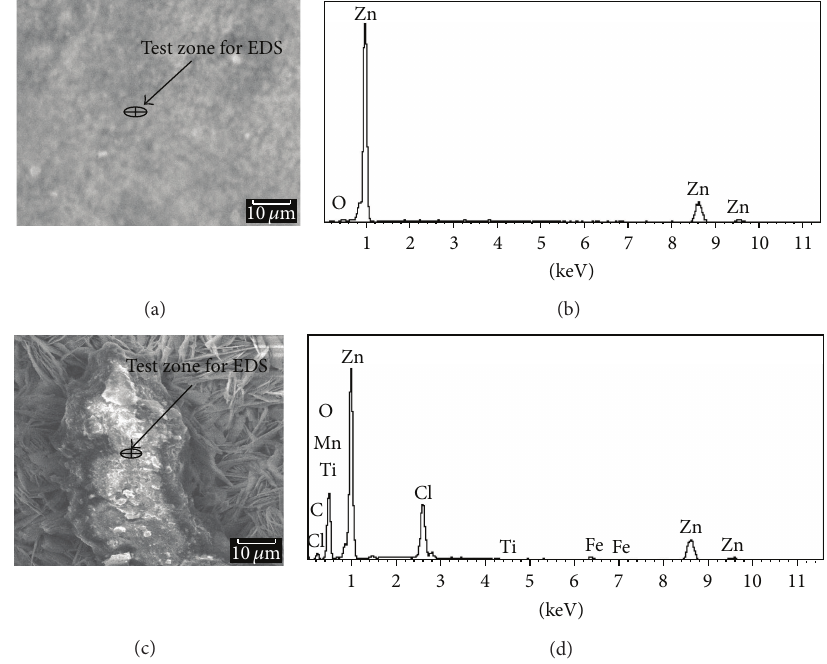
Figure 10: SEM and EDS analysis of galvanized steel immersed in CRS solution in 0.1MPa. (a) SEM image of galvanized steel before immersion; (b) EDS result of (a); (c) SEM image of galvanized steel immersed in CRS solution at 0.1MPa hydrostatic pressures after 14 days; (d) EDS result of (c) in the pitting area.